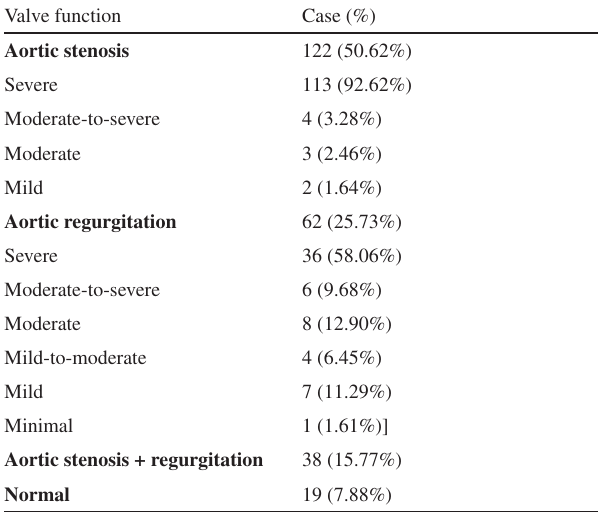
BAV=bicuspid aortic valve; TAV=tricuspid aortic valve. Table 3 - Functional parameters of the bicuspid aortic